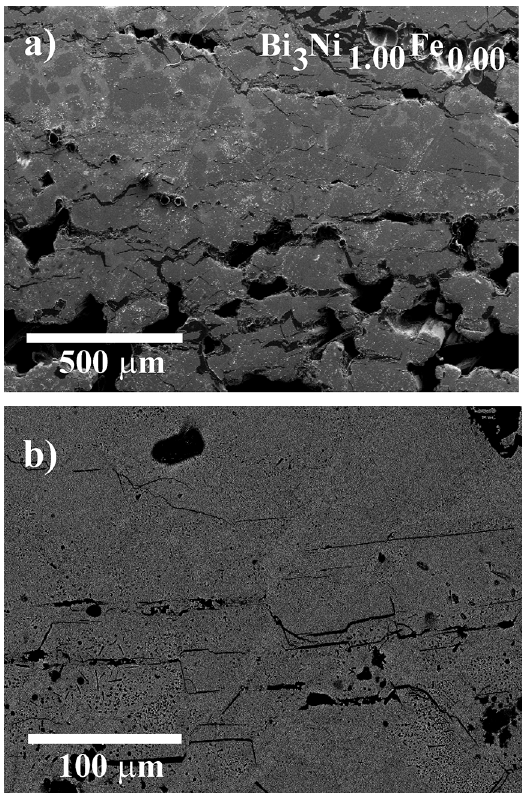
Figure 2. (a) Backscattered electrons SEM image of the polycrystalline of Bi